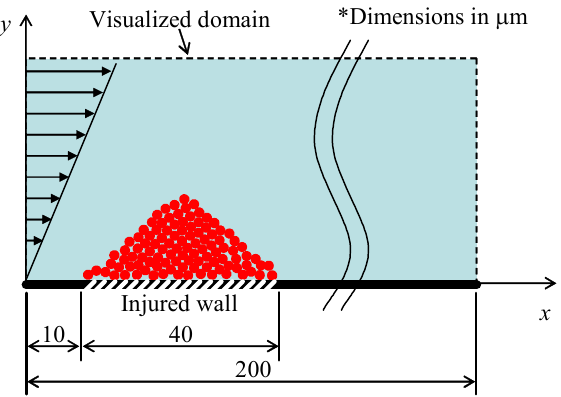
Fig. 2 Monolayer model for the destruction process of the primary thrombus. Couette flow was given for the background flow field. The surface, where the contact force was estimated, was set on y = 0. The injured site, where the binding force was estimated, was set on the region x = 10-50 [ µ m]. Particles were piled up above the injured site in shape of Gaussian distribution, simulating the primary thrombus.